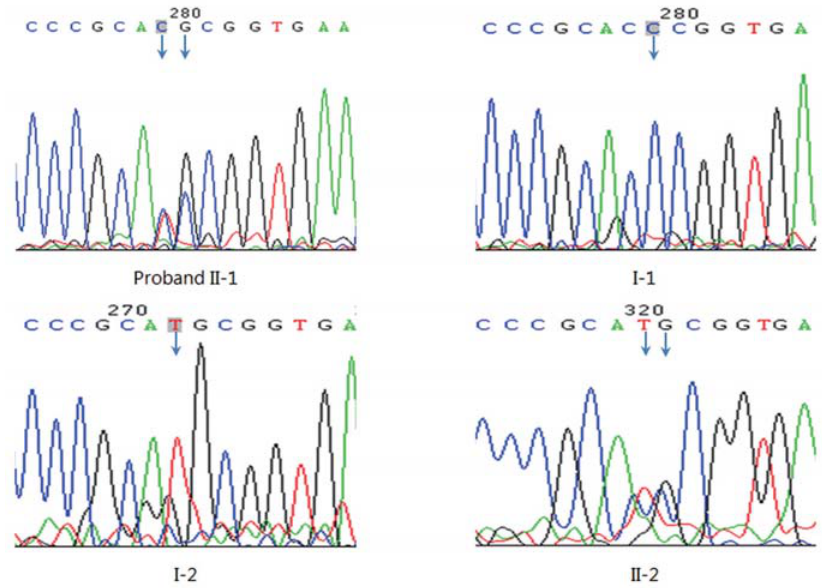
Figure 5- DNA-sequencing chromatograms of exon3 of PAX9 in the female proband (II-1) and her family members A variant of PAX9 gene {G718C (rs4904210) } was detected in the heterozygous state in the female proband (II-1). The same variant in the homozygous state was present in her father (I-1) and heterozygous state in her young brother (II-2), but not in her unaffected mother